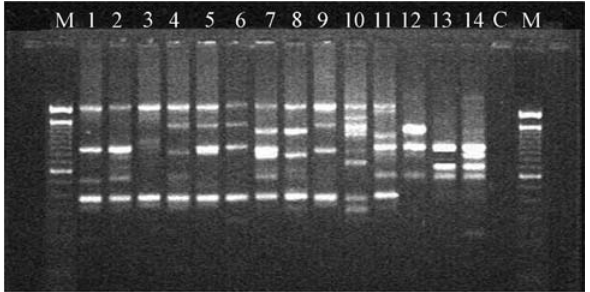
Figure 4 - Electrophoretic pattern of primer OPS-04 in Hypochaeris spe- cies: 1-3 = H. brasiliensis (populations of Guaíba, RS; Curitiba, PR and Piracicaba, SP), 4 = H. grisebashii , 5-6 = H. megapotamica (populations of Guaíba and Capão da Canoa, RS), 7 = H. microcephala var albiflora , 8 = H. microcephala var microcephala , 9 = H. pampasica , 10 = H. rosengurttii ,11= H.variegata ,12-13= H.glabra (populationsofCuritiba